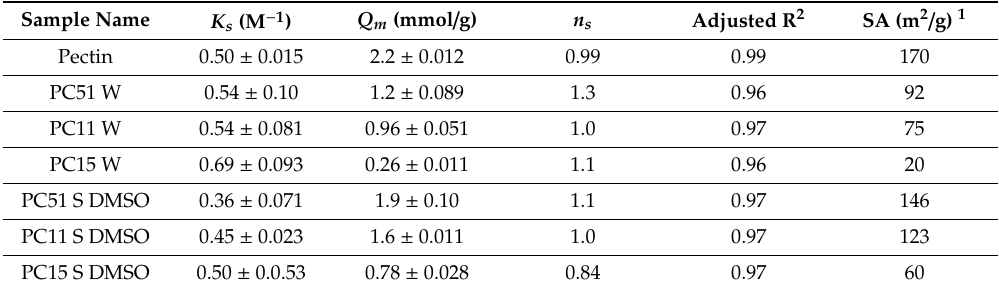
Figure 4. Methylene blue (MB) dye uptake isotherms for pectin and pectin–chitosan composites, where the solid lines represent best-fit results by the Sips isotherm model. Table 1. Sips model fitting parameters for methylene blue (MB) dye uptake by pectin and pectin–chitosan composite adsorbents.